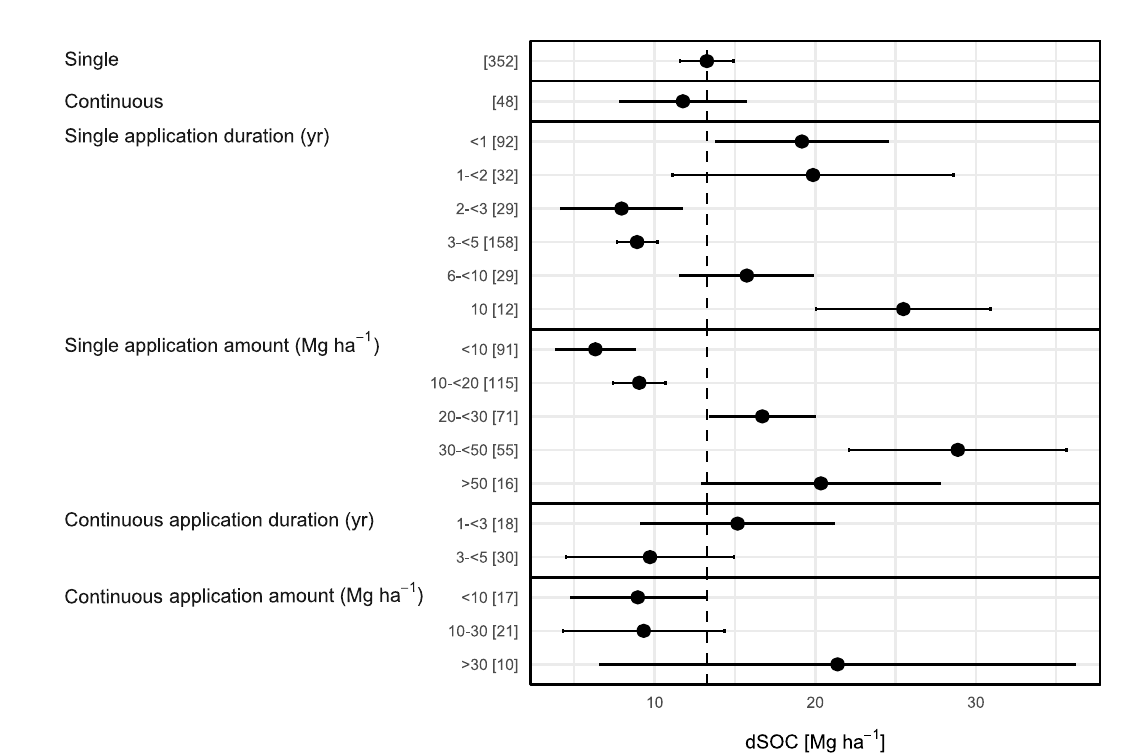
Figure 5. Meta-analysis results of the “field dataset”, given as a forest plot. Presented is the absolute mean difference of soil organic carbon stocks (dSOC) after the application of biochar influenced by whether the application was conducted once (single application) or repeatedly (continuous application). Points within the range represent the mean dSOC and the line within the 95% confidence interval represents the range of the effect size. If the effect size range crosses the “zero-effect-line”, given as a solid vertical line at 0%, the result can be interpreted as statistically insignificant. The effect sizes of each group were considered to be significantly different at p < 0.05 from each other if the 95% confidence intervals were not-overlapping. A vertical black dotted line represents the grand overall